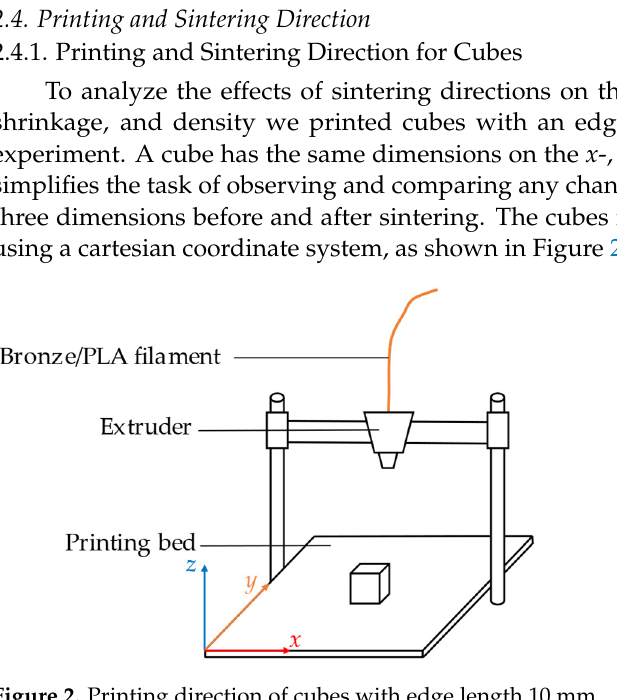
Figure 1. Scheme of bronze/PLA hybrid filament coupled with FFF process.